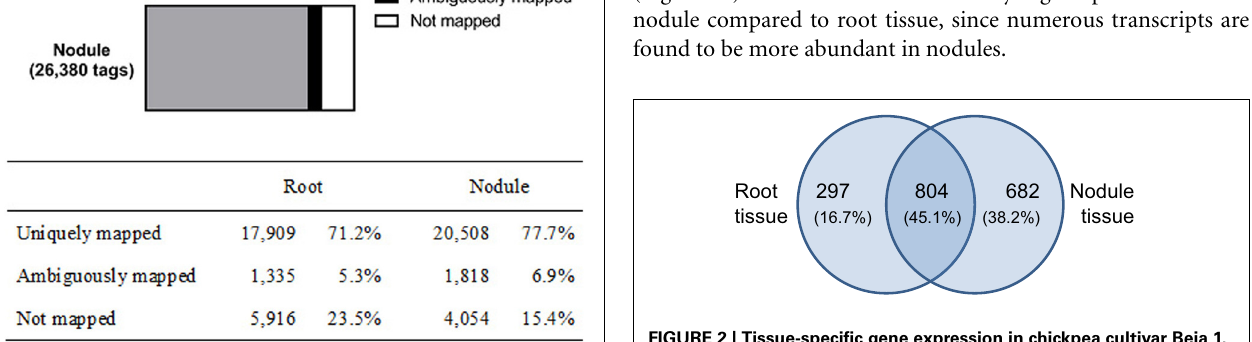
FIGURE 1 | Genomic mapping results of the captured transcriptomes from chickpea root and nodule tissue.